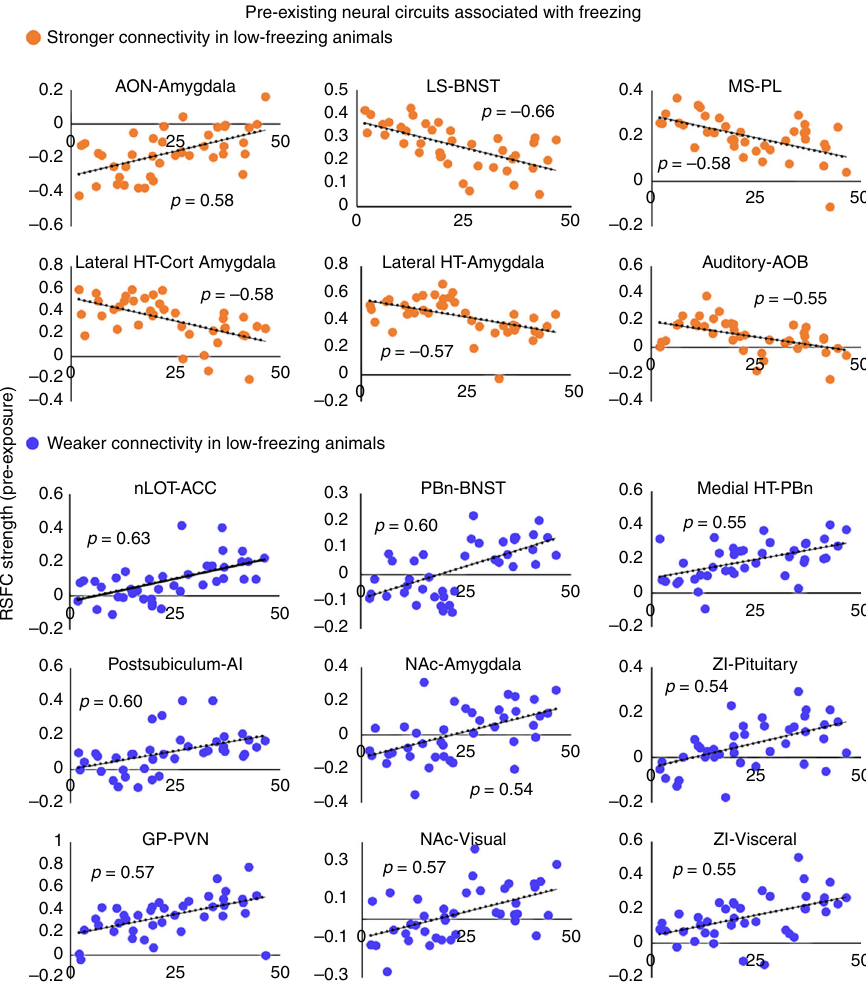
Fig. 5 Correlations between pre-existing functional connectivity and freezing. Neural circuits with pre-trauma RSFC ( y -axis) correlated ( p < 0.05, FDR corrected) with freezing time ( x -axis) in all fox-urine exposed animals. AON, anterior olfactory nucleus; LS, lateral septum; BNST, bed nucleus of the stria terminalis; MS, medial septum; PL, prelimbic cortex; HT, hypothalamus; Cort Amygdala, cortical amygdala; AOB, accessory olfactory Bulb; nLOT, lateral olfactory tract nucleus; ACC, anterior cingulate cortex; PBn, parabrachial nucleus; AI, agranular insula; NAc, nucleus accumbens; ZI, zona inserta; GP, globus pallidus; PVN, paraventricular nucleus. Source data of Fig. 5 are provided as a Source Data fi